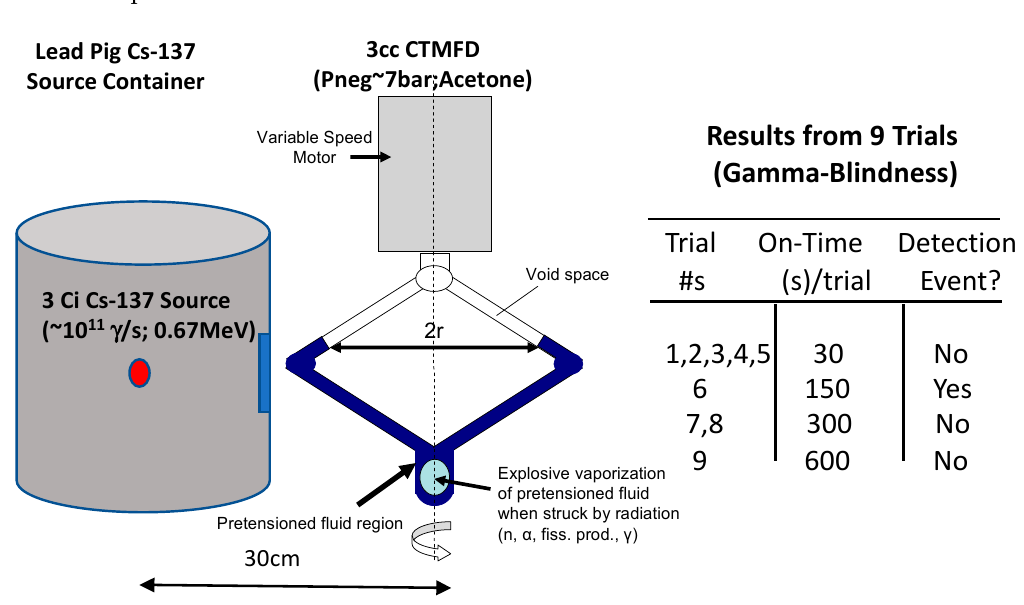
Figure 7. Schematic representation of gamma blind neutron detection using a 3 Ci (Cs-137) gamma source alongside results of various trials.